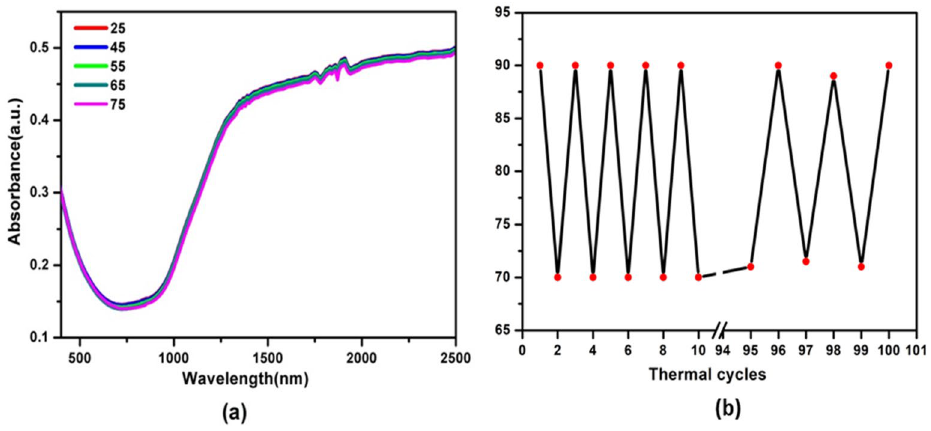
Figure 6. ( a ) Absorption spectra of ITO-NC@PEG/PCL (INPP) at between 25–75 °C. ( b ) Changes of transmittance of ITO-NC@copolymer/PCL (INCP) at λ = 1,000 nm during heating and cooling cycles between 25 and 75 °C.